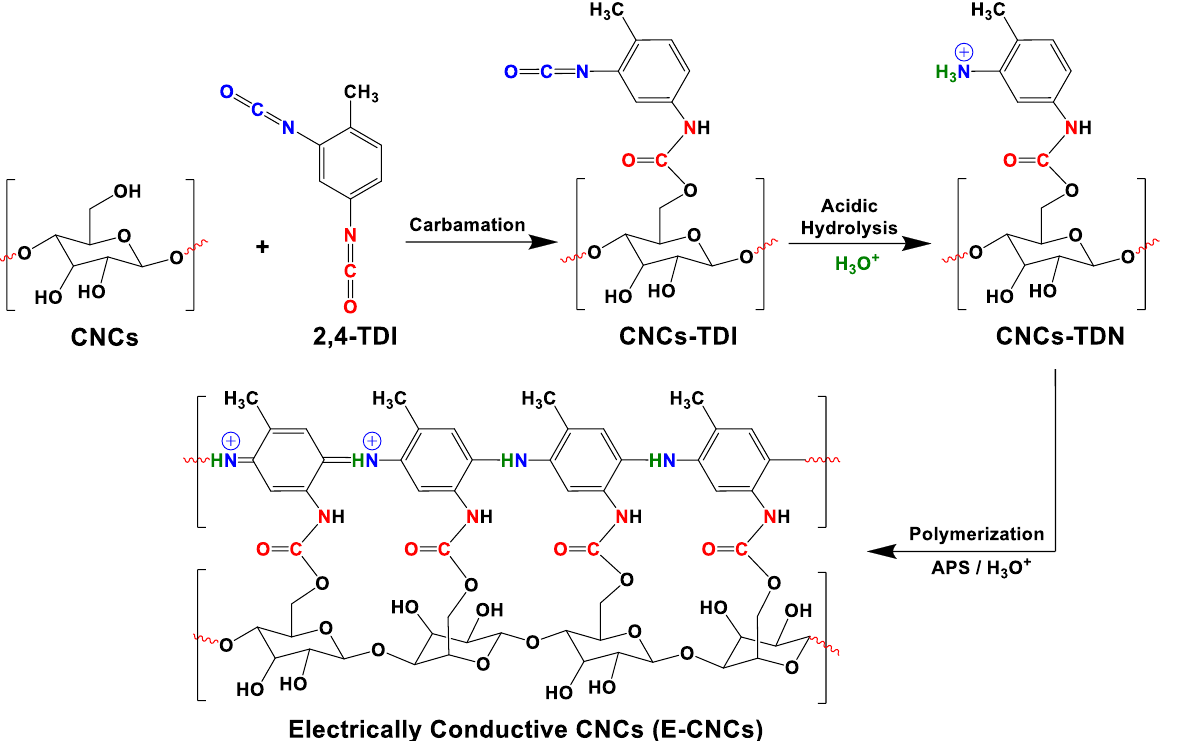
Figure 3. The growth of a poly(o-toluidine) nanoshell on the CNC surface using 2,4-TDI as the main reagent.